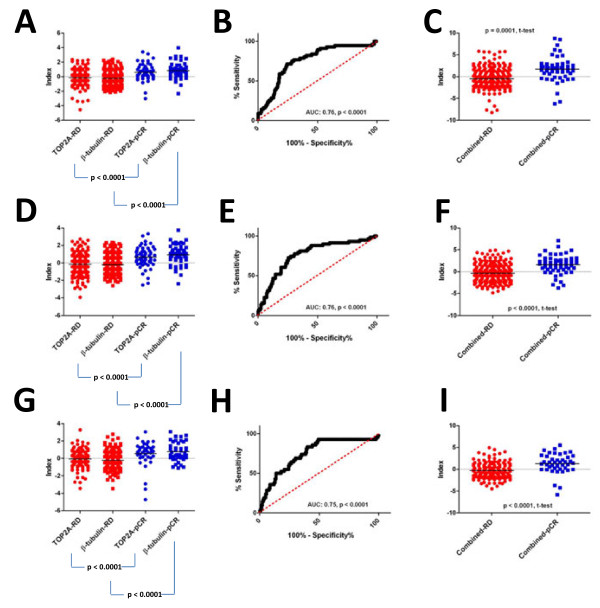
TOP2A and β-tubulin combination index predicts response to multi-agent anthracycline/taxane chemotherapy.A) Individual target index scores ( A: TOP2A index, T: β-tubulin index) in patients who experienced complete pathological response or had residual disease after TFAC neoadjuvant chemotherapy (GSE21094, p < 0.0001 both cases, t-test). B) ROC analysis of combination index scores and response to TFAC neoadjuvant chemotherapy (AUC: 0.78, p < 0.0001). C) Combination index scores in patients who experienced pCR or had RD after neoadjuvant chemotherapy ( p < 0.0001, t-test). D) Individual target index scores of patients who experienced pCR or had RD after AT neoadjuvant chemotherapy (GSE25055, p < 0.0001 both cases, t-test). E) ROC Analysis of combination index scores and response to AT neoadjuvant chemotherapy for GSE25055 (AUC: 0.78, p < 0.0001). F) Combination index scores of patients who experienced pCR or had RD after AT neoadjuvant chemotherapy ( p <0.0001, t-test). G) Individual target index scores of patients who experienced pCR or had RD after AT neoadjuvant chemotherapy (GSE25065, p < 0.0001 both cases, t-test). H) ROC analysis of combination index scores and response to AT neoadjuvant chemotherapy for GSE25065 (AUC: 0.75, p < 0.0001). I) Combination index scores of patients who experienced complete pathological response or had residual disease after AT neoadjuvant chemotherapy ( p < 0.0001, t-test).